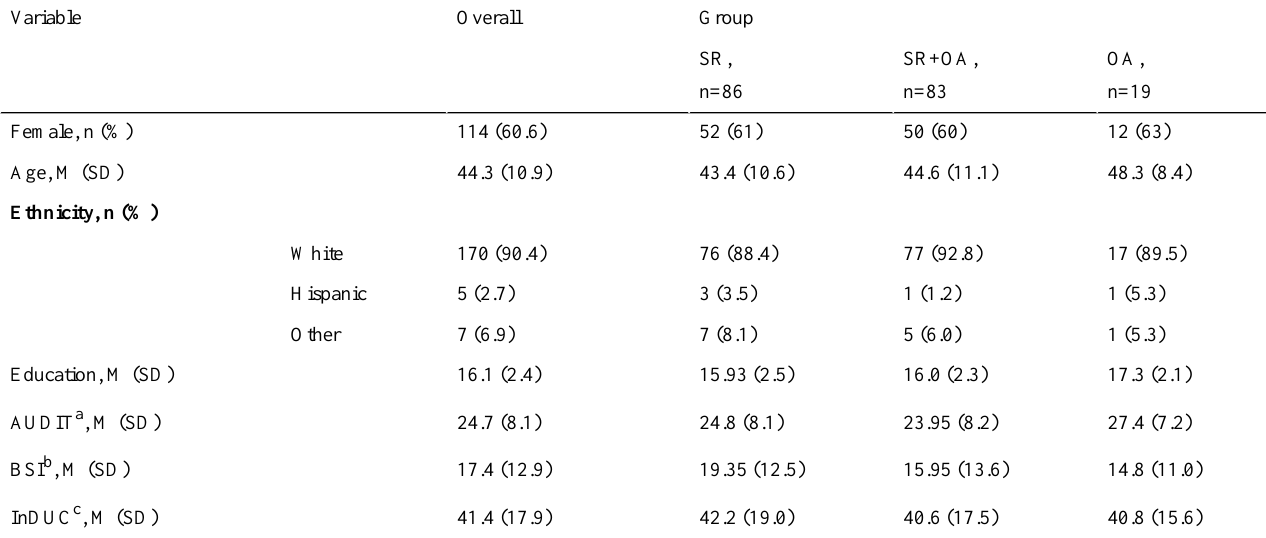
Table 1. Pretreatment characteristics of participants by group.